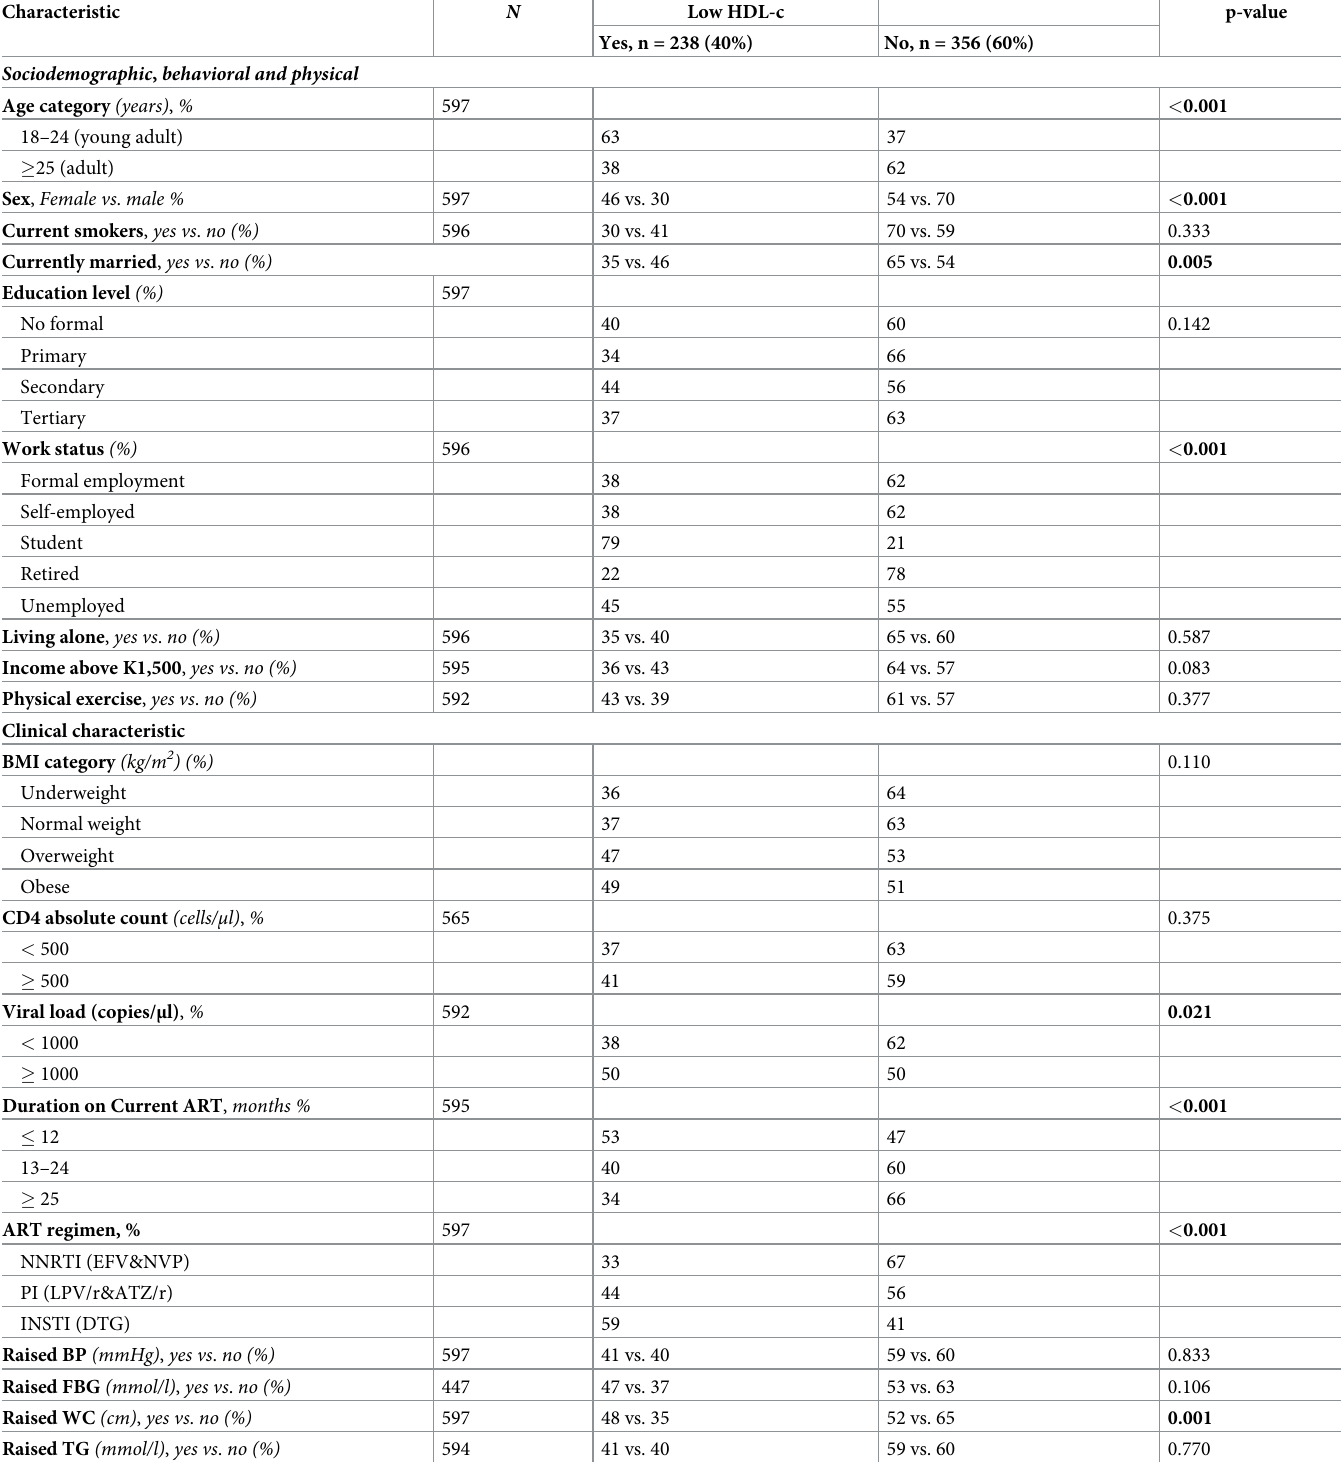
Table 1. Sociodemographic, behavioral, physical and clinical factors sorted according to low HDL-c status. Characteristic